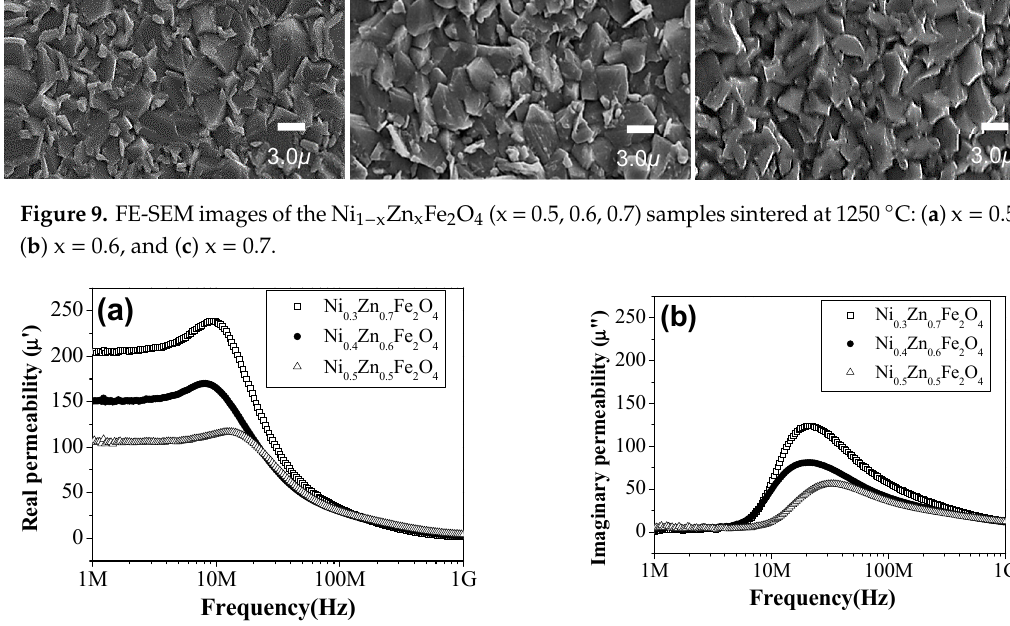
Figure 10. Real part ( a ), and imaginary part ( b ) of the magnetic permeability of Ni 1 − x Zn x Fe 2 O 4 (x = 0.5, 0.6, 0.7) toroidal samples in the frequency range from 1 MHz to 1 GHz.